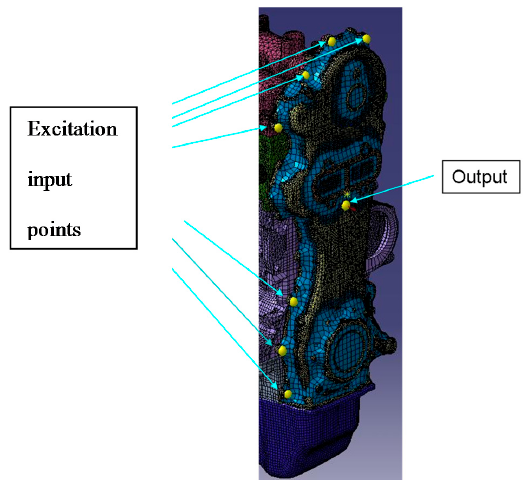
Figure 6. Vibro-acoustic model for the vibration analysis.